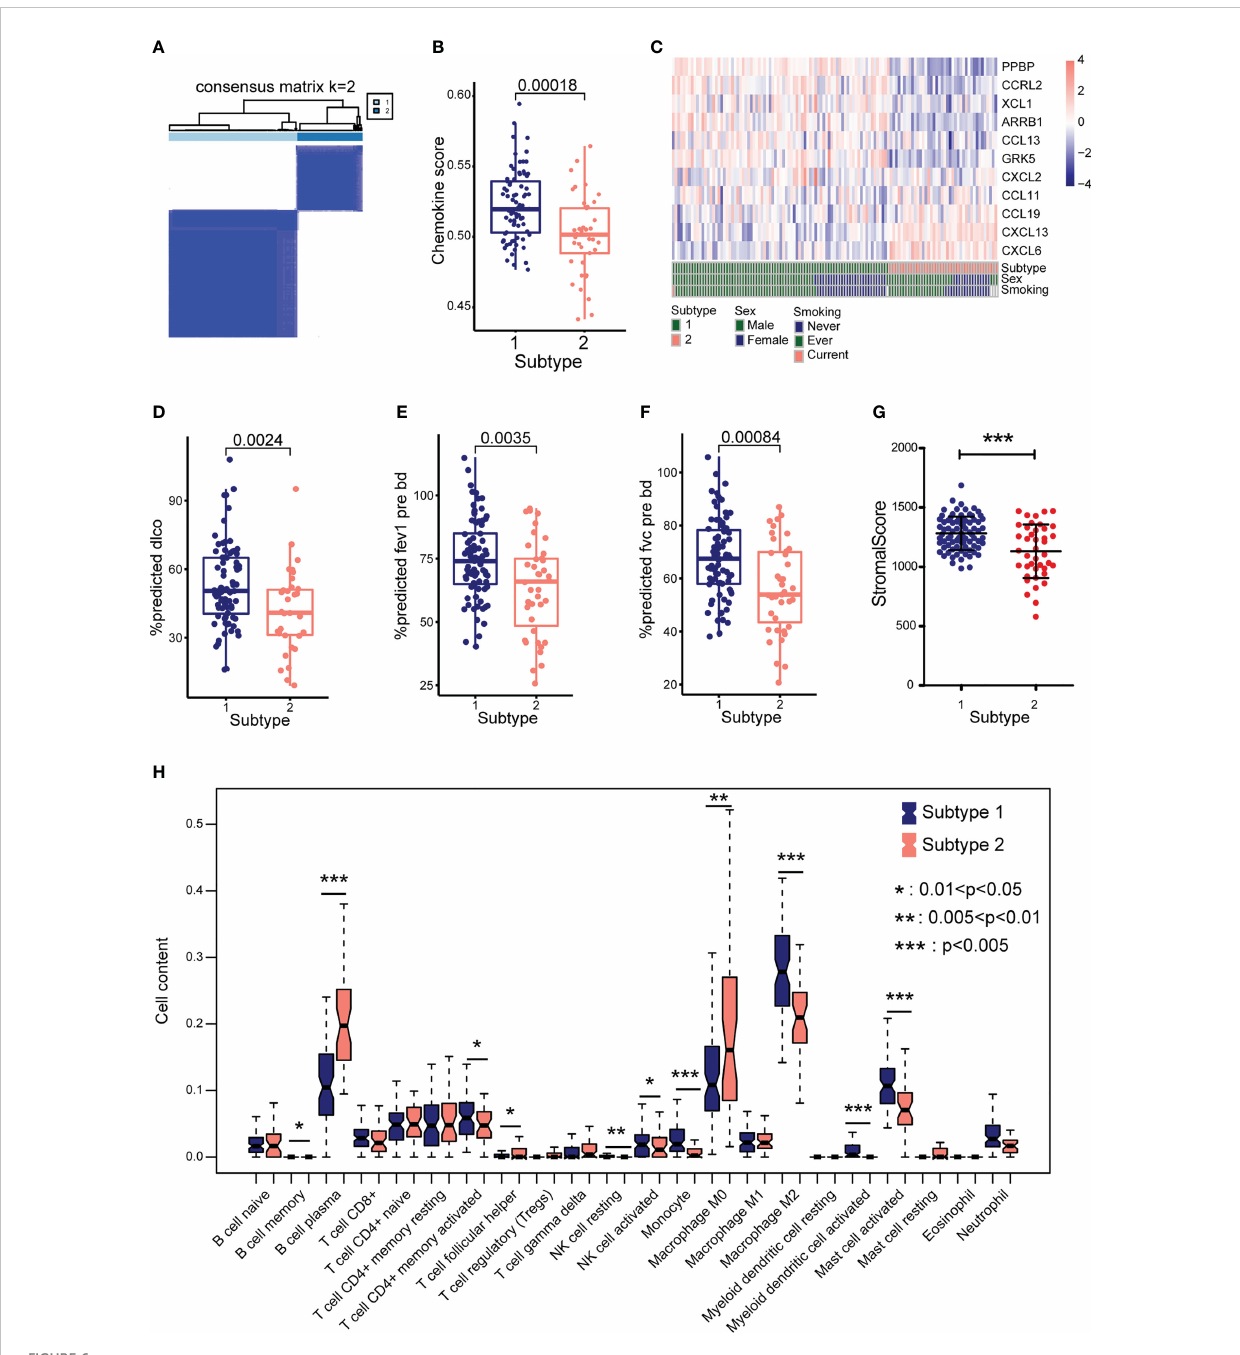
FIGURE 6 Identify different subtypes based on eleven CR-DEGs. (A) Hierarchical map of subtype analysis. (B) The chemokine score between the two subtypes. (C) Distribution of the eleven CR-DEGs in GSE47460 cohorts in subtype, sex, and smoking. (D) The pulmonary function parameters, dlco (D) , fev1 (E) , and fvc (F) in two subtypes. (G) Stromal score in two subtypes. (H) The proportion of 22 types of immune cells in two